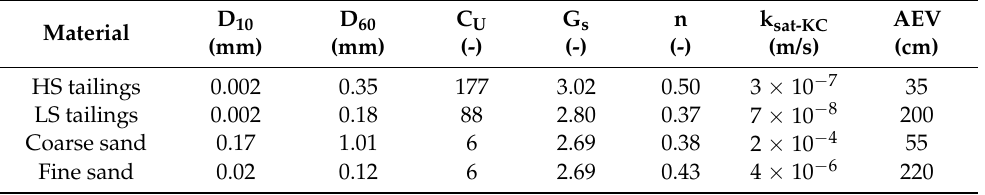
Table 3. Physical and hydraulic properties of the tested materials. D 10 : 10% passing, D 60 : 60% passing, C U : coefficient of uniformity (C U = D 60 /D 10 ), G s : specific gravity, n: porosity, k sat-KC : saturated hydraulic conductivity at porosity n, predicted with the Kozeny-Carman model; AEV: air-entry